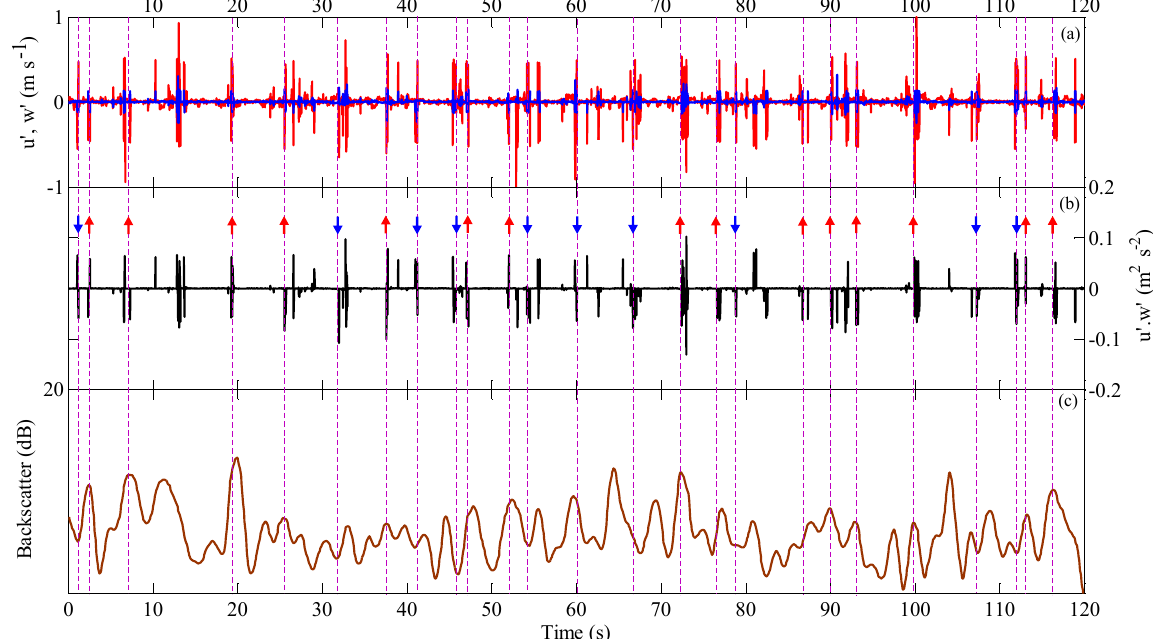
Figure 5. Time series records from below the measured mean critical velocity experiment ( u < u cr,measured ): (a) turbulent velocity ( u (cid:48) ,w (cid:48) ); (b) turbulent Reynolds shear stress ( u (cid:48) ,w (cid:48) ), showing the ejection (red upward arrows) and sweep (blue downward arrows) events; (c) 1s mean of the